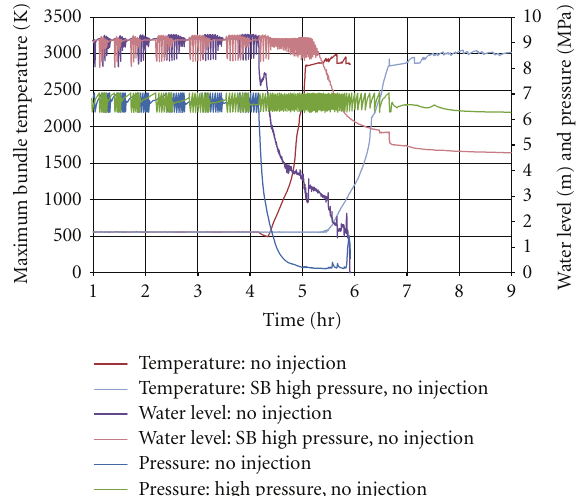
Figure 21: Maximum bundle temperature, water level, and reactor vessel pressure for scenarios with and without water injection after the start of core uncovery (all emergency water injection was terminated at 4.2 hours after reactor scram).